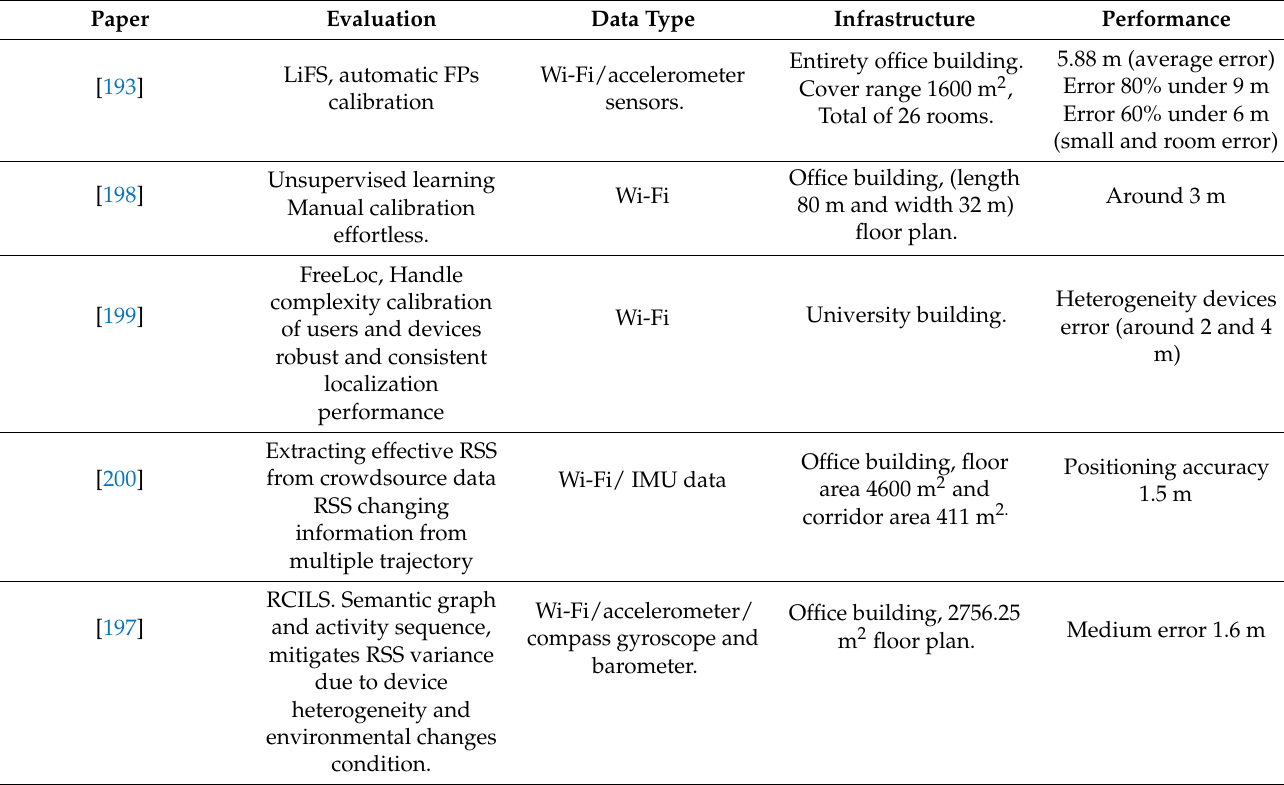
Table 4. Comparison of location accuracy based on